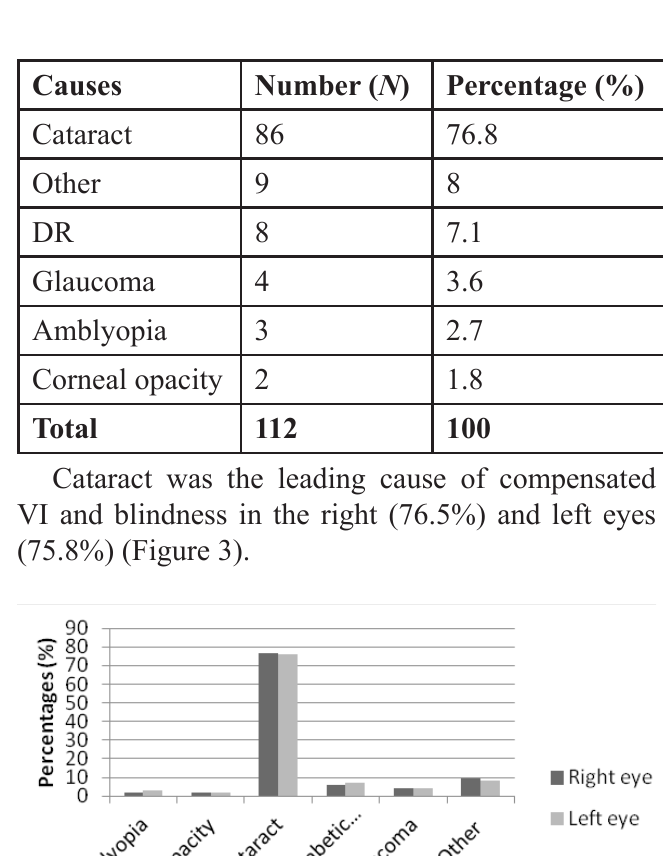
Table 4: The causes of visual impairment and blindness in eyes of participants following optical compensation.